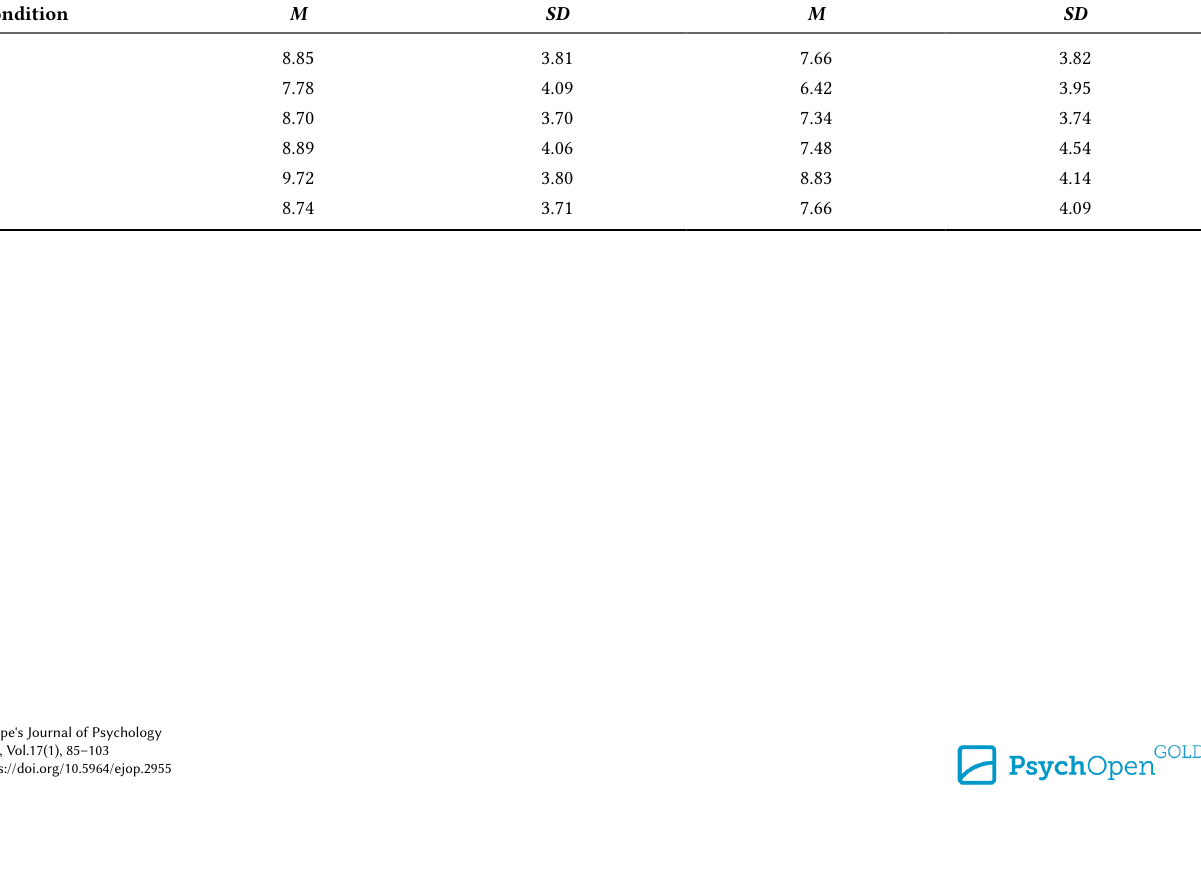
Memory Results (Words Recalled) for Experiment 1